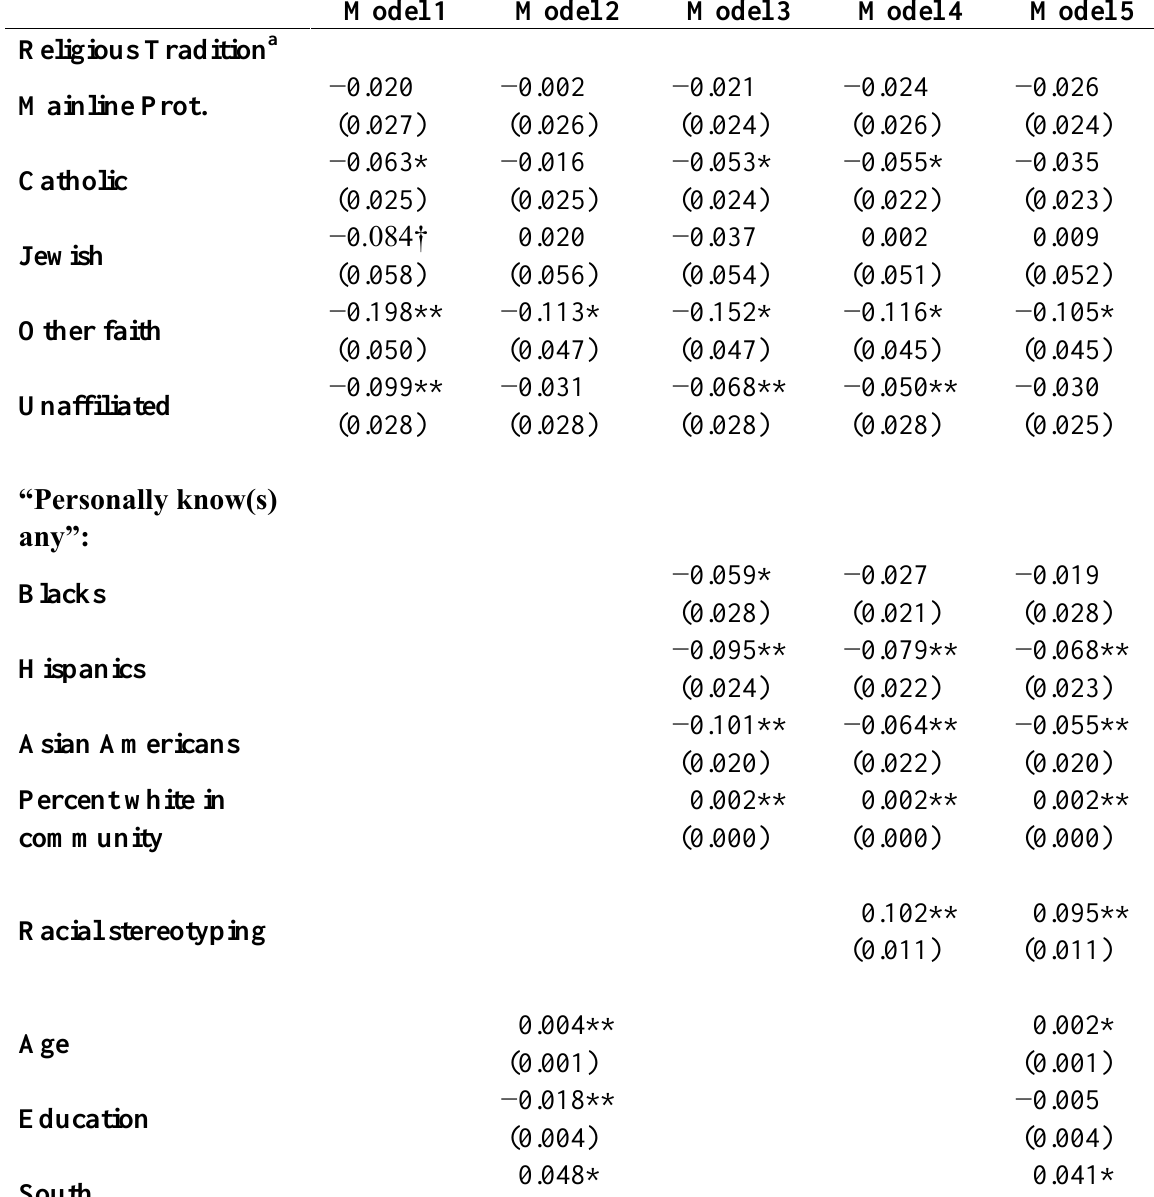
Table 5. Preference for Same-Race Neighbors Among Other White Religious Groups Compared to White Evangelical